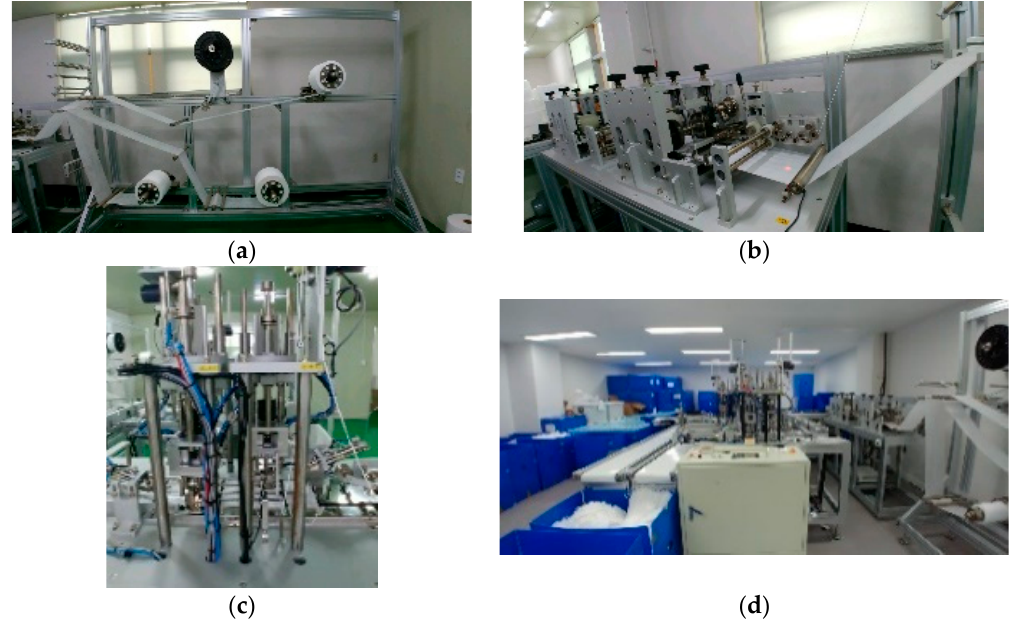
Figure 4. Mask production factory. The non-woven fabric, nose support, and filter are made in a ( a ) materials supply unit. Mask forming is conducted in a ( b ) forming unit. Ear loops are attached in ( c ) ear loop unit 1 and ( d ) ear loop unit 2.